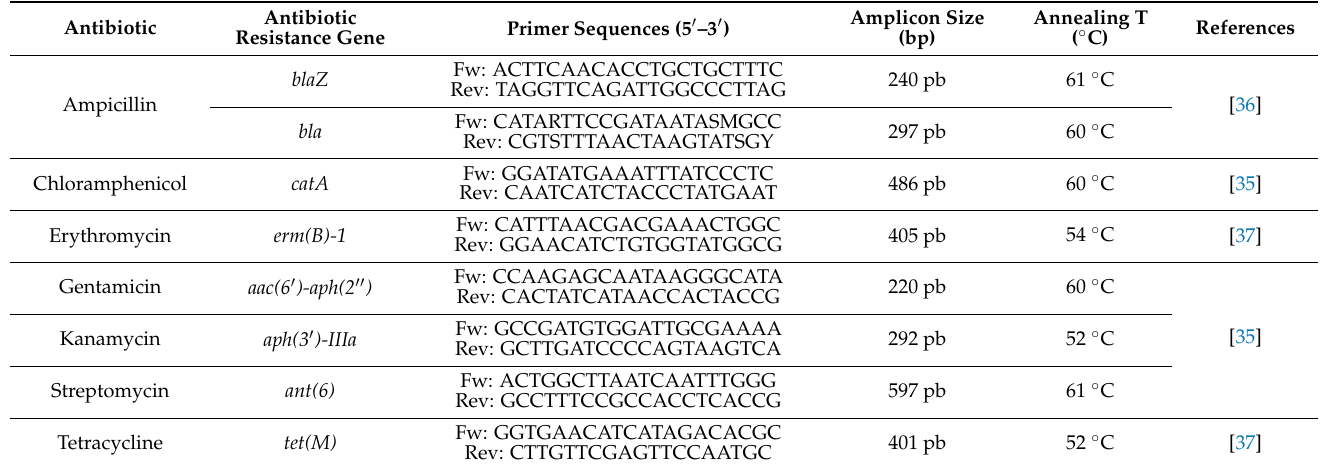
Table 3. Primers for antibiotic resistance genes. Antibiotic Antibiotic Resistance